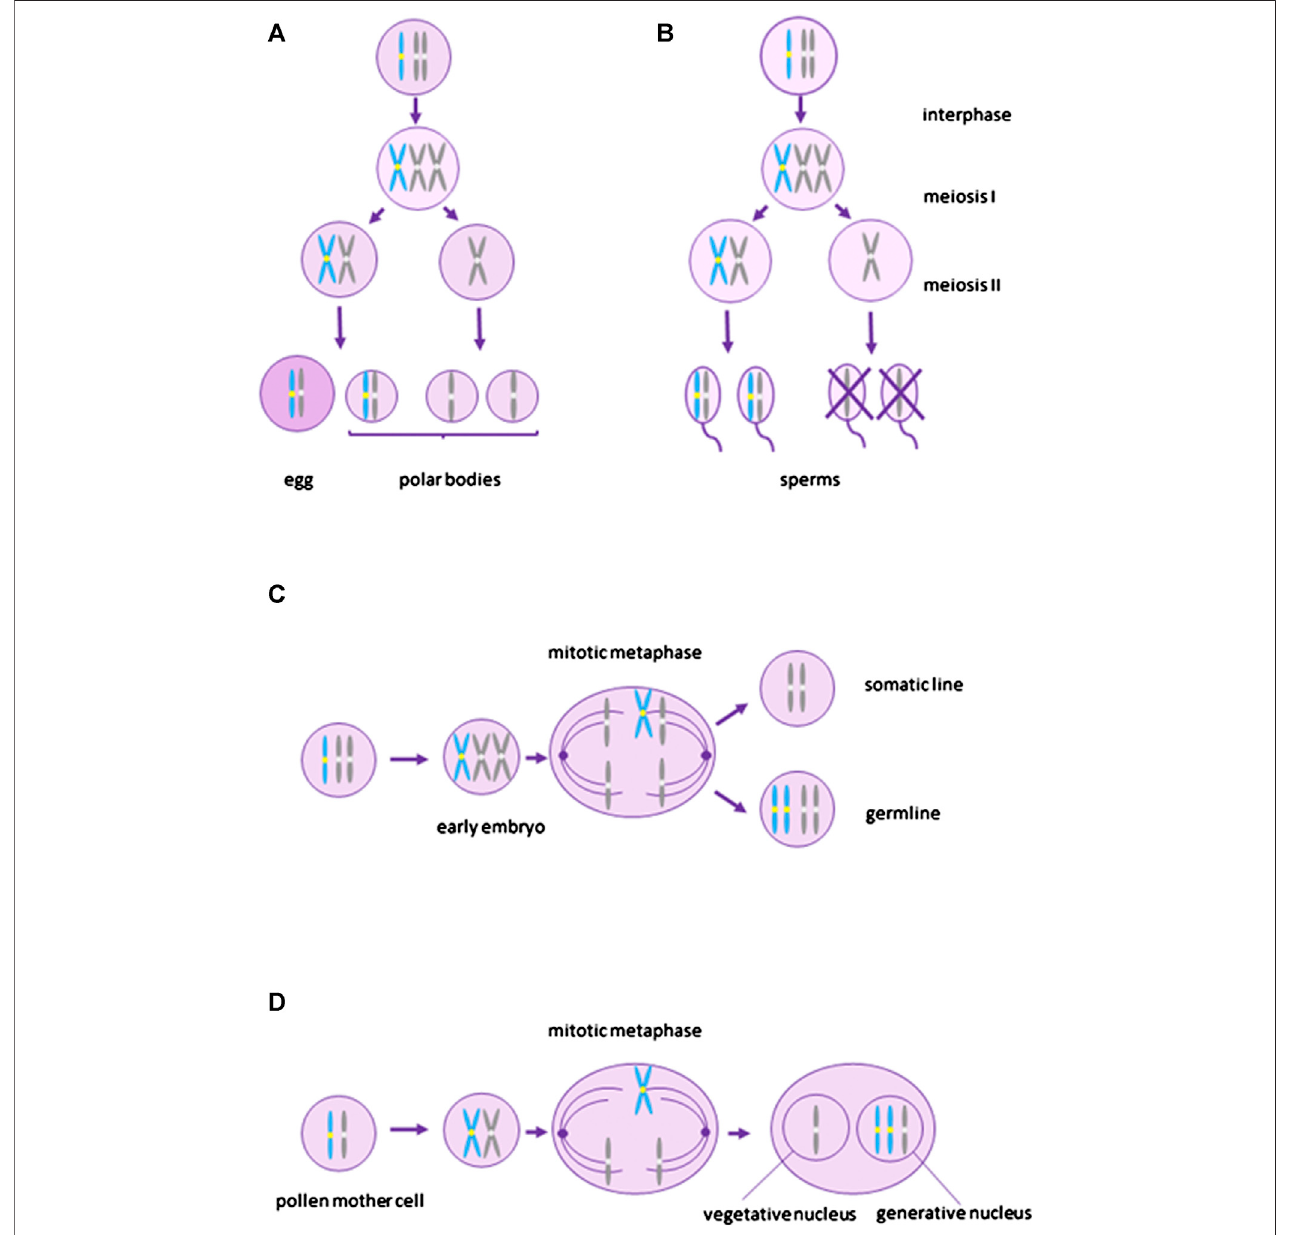
FIGURE 1 | Depiction of transmission mechanisms of B chromosomes. (A) and (B) represent meiotic drive. (A) – female meiotic drive where the B chromosome segregatespreferentiallyintotheegg, (B) – malemeioticdrivewherespermswithoutBdonotsurvive. (C) and (D) representmitoticdriveassociatedwithgonotaxiswhere B chromosomes preferentially segregate into the germline (C) – premeiotic mitotic drive during early embryo development when the germline is being determined, (D) – postmeiotic mitotic drive in plants during gametophytic phase. Blue represents B chromosomes and grey represents A